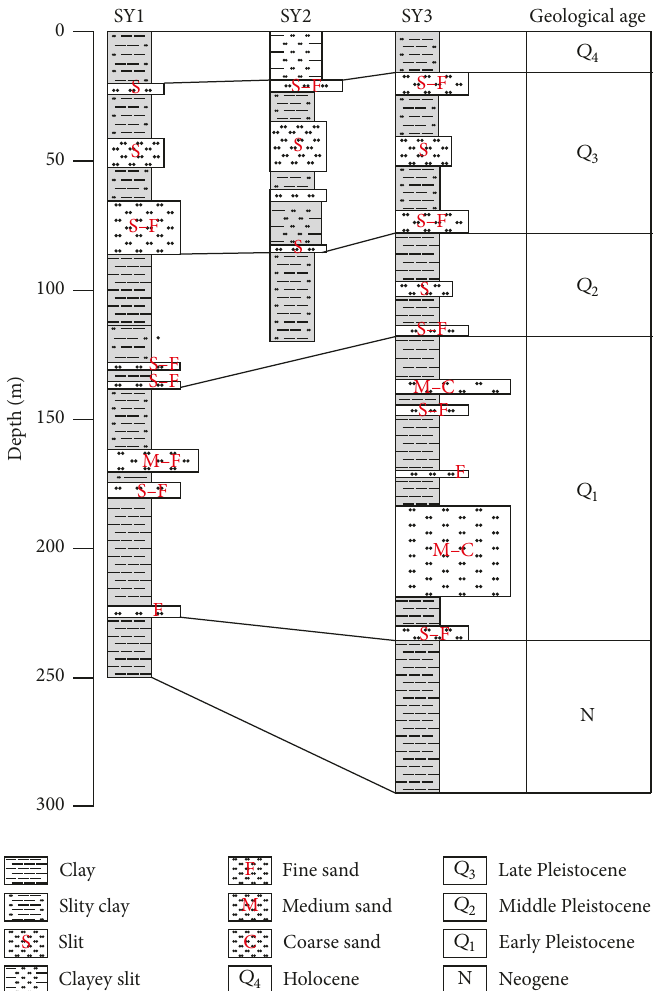
Figure 3: Stratigraphic columns of the drilled three boreholes in North Jiangsu coastal plain. The observed deposit distributions across the cores are